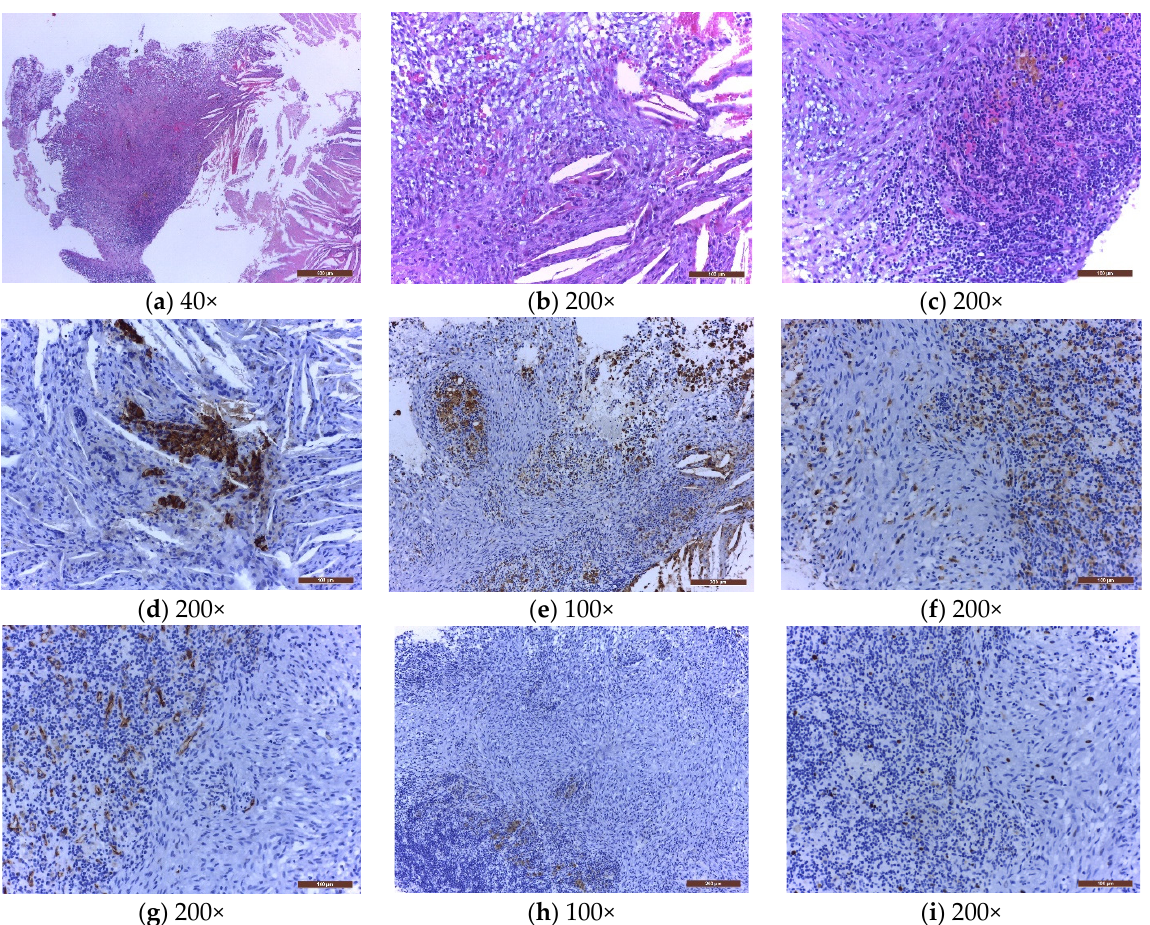
Figure 1. The microscopical examination of a sellar xanthogranuloma ( a ) solid area formed by a mixture of tumoral/inflammatory cells, and clear acicular cholesterol crystals, at low magnification (40×); ( b ) mixture of foam cells, spindle cells, rare lymphocytes, and cholesterol crystals with foreign body multinucleated giant cells around them (200×); ( c ) mixture of spindle cells, large number of lymphocytes, plasma cells, erythrocytes, golden brown siderophages, and small vessels (200×); ( d ) cholesterol crystals and a few remnants of dark brown pituitary glandular cells, positive for chromogranin A; ( e ) dark brown macrophages (foam cells, histiocytes, some spindle cells, and multinucleated giant cells), positive for CD 68 (100×); ( f ) dark brown macrophages (histiocytes and some spindle cells), positive for Factor XIIIa (200×); ( g ) small vessels with dark brown endothelial cells, positive for CD34 (200×); ( h ) spindle cells negative for TTF1 (100×); ( i ) low Ki67 expression in spindle cells and lymphocytes (200×). Hematoxylin and eosin ( a – c ) and immunohistochemistry ( d – i ). The nature of the spindle cells raised several differential diagnoses. Immunohistochemically, regardless of their type (histiocytes, foam cells, siderophages, foreign body giant cells), all the